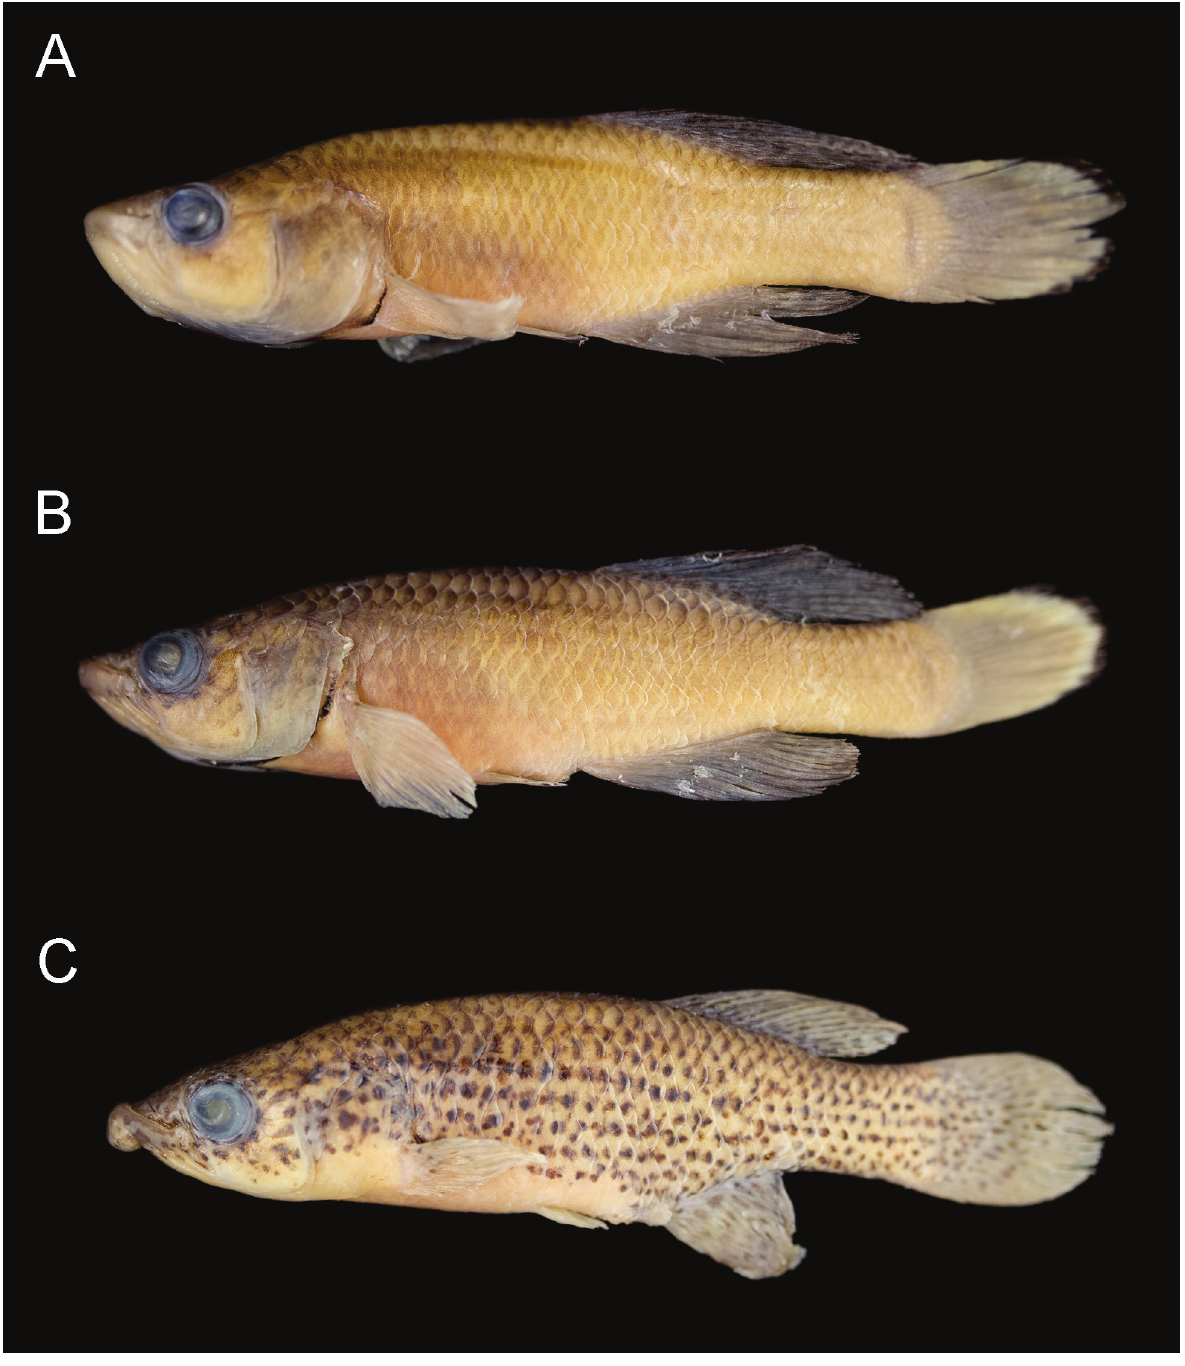
Figure 1. Nothobranchius lucius : A. MRAC A7-02-P-9, holotype, male, 49.6 mm SL; Tanzania: 2 km S of Ifakara; B. MRAC A7- 02-P-26-27, male, 59.4 mm SL; Tanzania: 1 km S of Minepa; C. MRAC A7-02-P-26-27, female, 55.8 mm SL; Tanzania: 1 km S of